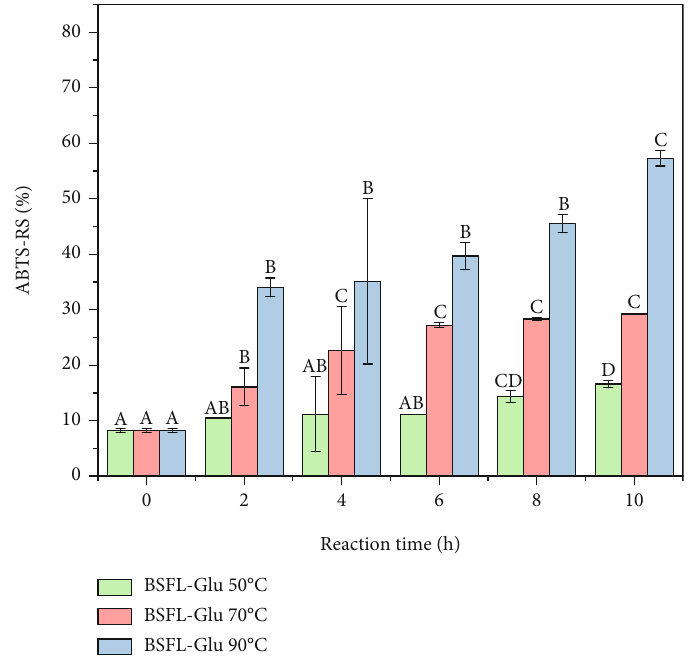
Figure 4: ABTS radical scavenging activity of BSFL-Glu MRPs as a function of reaction temperature. Values are mean ± standard deviation ; means with di ff erent superscript are signi fi cantly di ff erent at the same heating